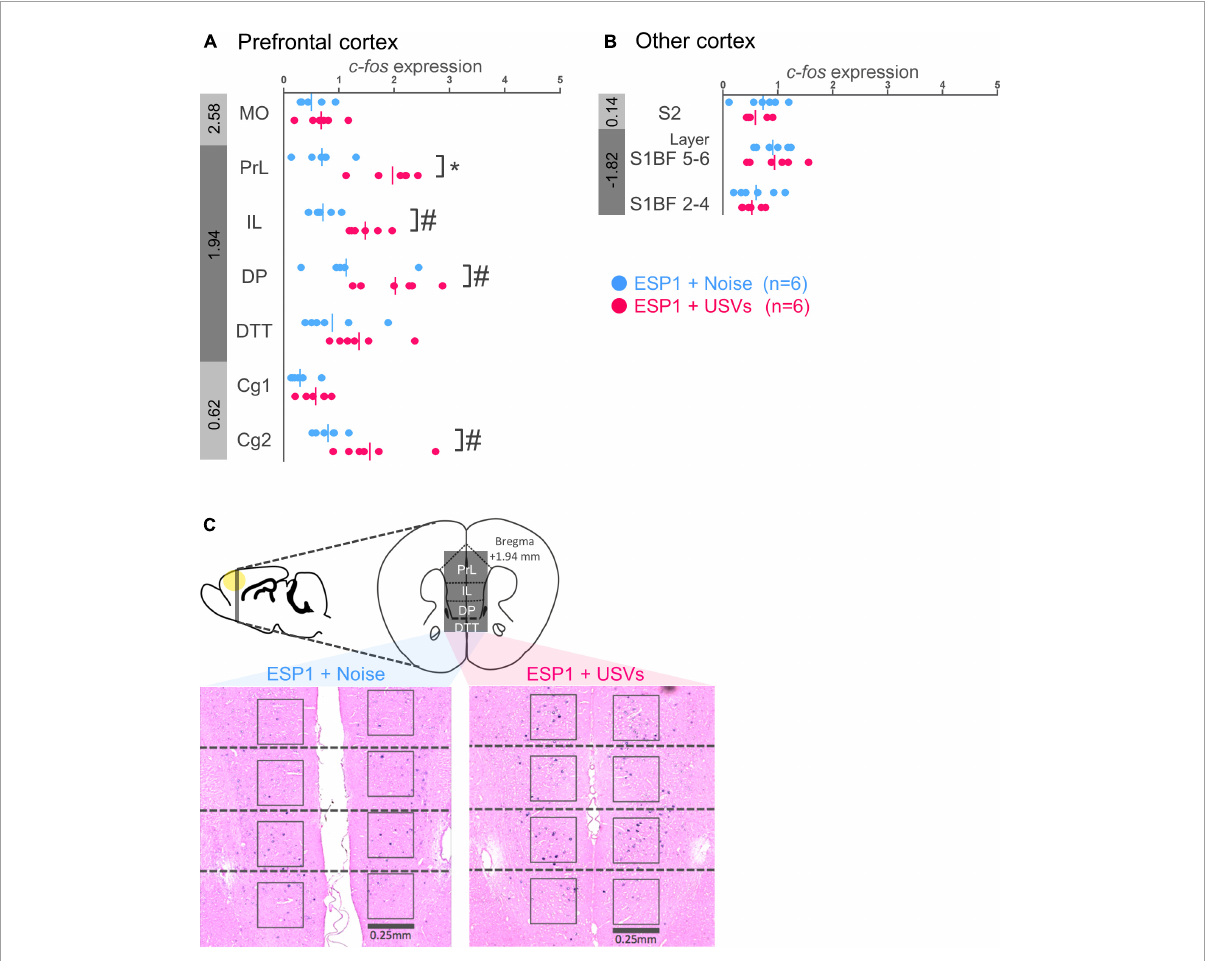
FIGURE2 Expression levels of c-fos mRNA in the prefrontal cortex (A) and other cortices (B) of female mice. Blue and red symbols represent individual data for (exocrine gland-secreting peptide 1) ESP1+noise and ESP1+USVs (ultrasonic vocalizations) conditions, respectively. Vertical lines indicate mean values. Numbers in gray bands indicate approximate anteroposterior distance to the bregma (mm). * p < 0.05 (Welch’s t -test followed by multiple comparisons correction), # p < 0.05 (Welch’s t -test; but not significant after multiple comparisons correction). (C) Representative images of c-fos mRNA expression in the prefrontal cortex. MO, medial orbital cortex; PrL, prelimbic cortex; IL, infralimbic cortex; DP, dorsal peduncular cortex; DTT, dorsal tenia tecta; Cg1, cingulate cortex, area 1; Cg2, cingulate cortex, area 2; S2, secondary somatosensory cortex; S1BF, primary somatosensory cortex barrel